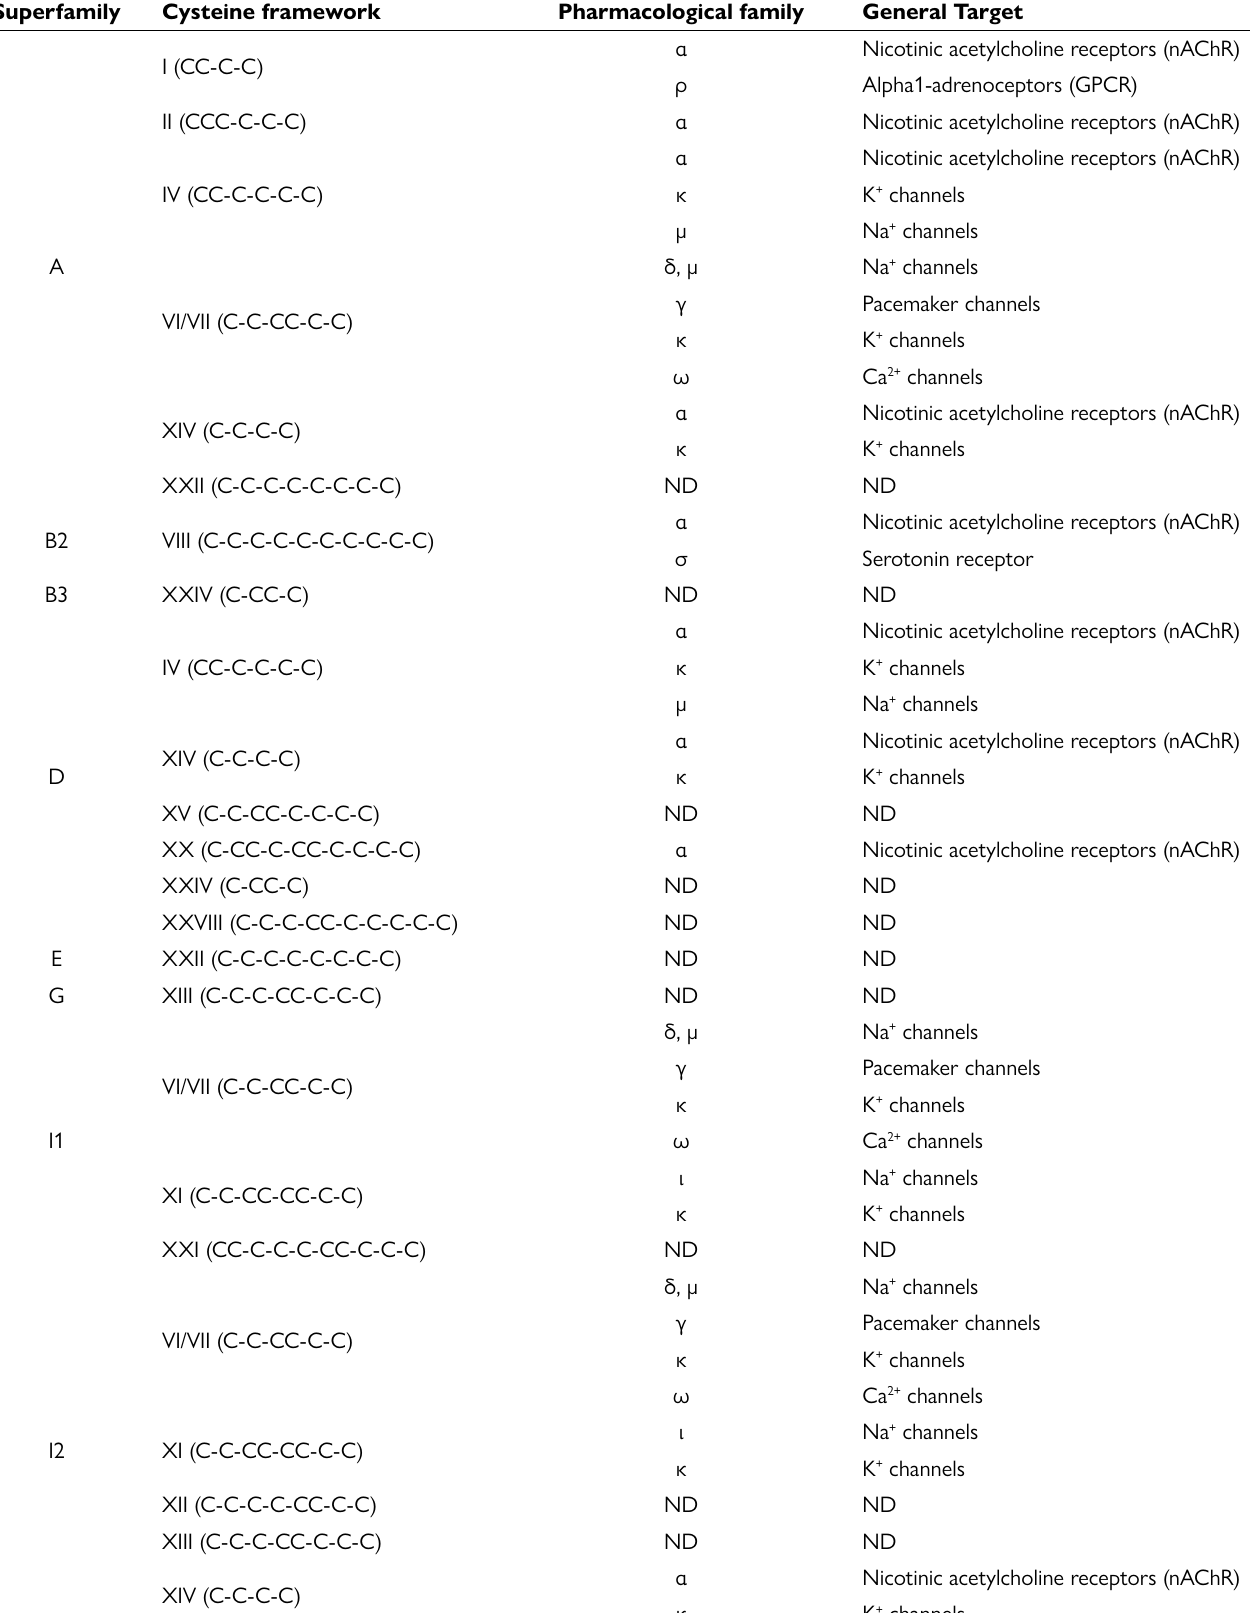
Table 2. Gene superfamily, cysteine framework, general targets, and pharmacological families of conotoxins according to ConoServer